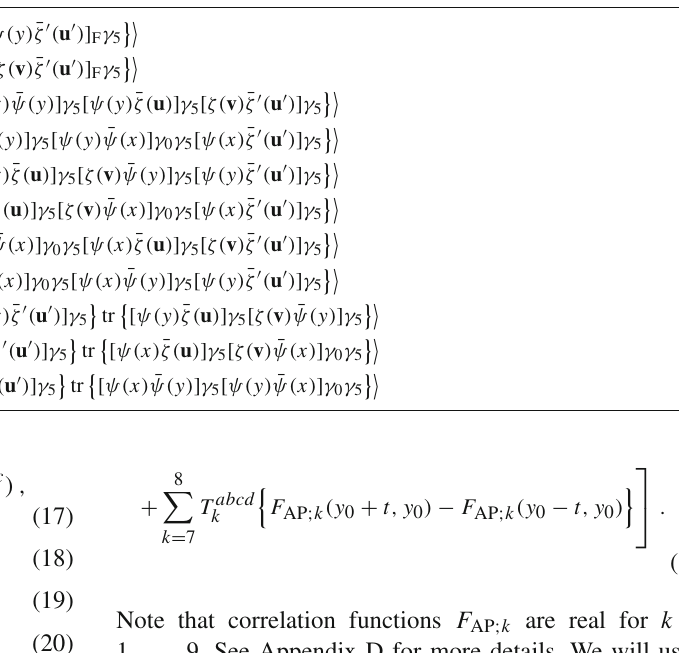
Table 1 Mathematical expressions for the diagrams F S ; k depicted in Fig. 1 and the diagrams F AP ; k depicted in Fig.